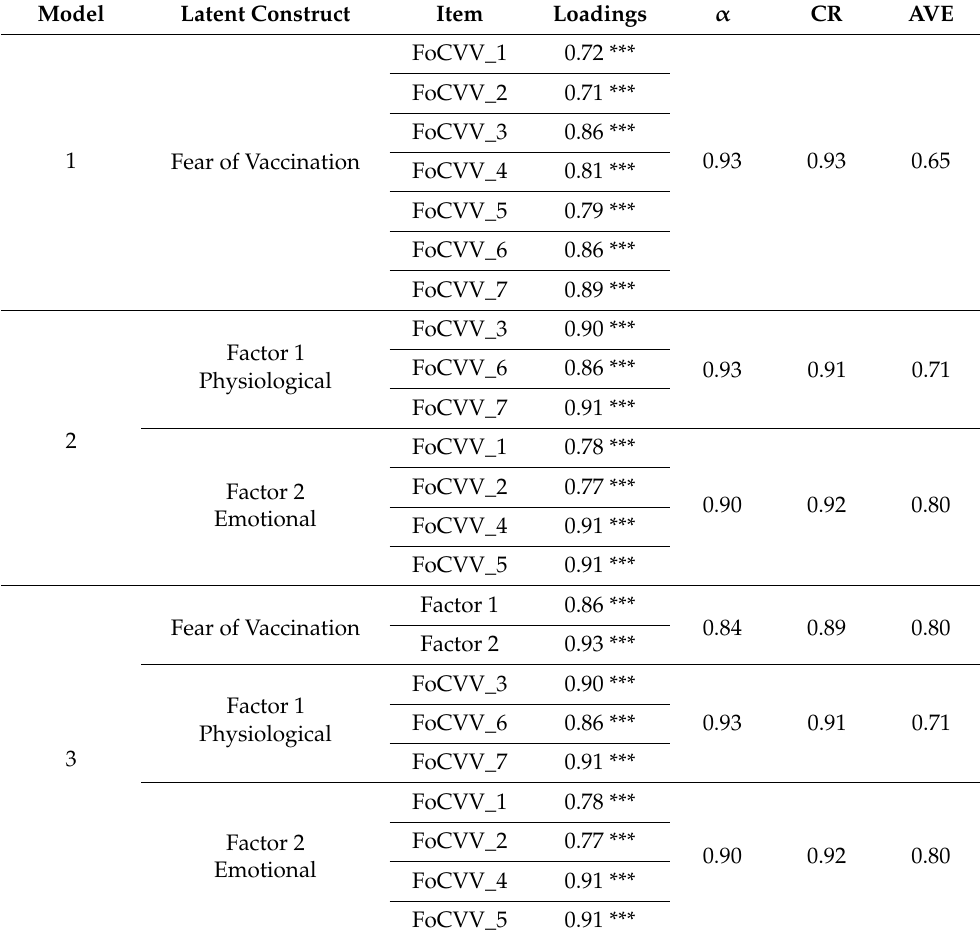
Table 2. Results of the confirmatory factor analysis for Fear of Coronavirus Vaccination Scale. Model